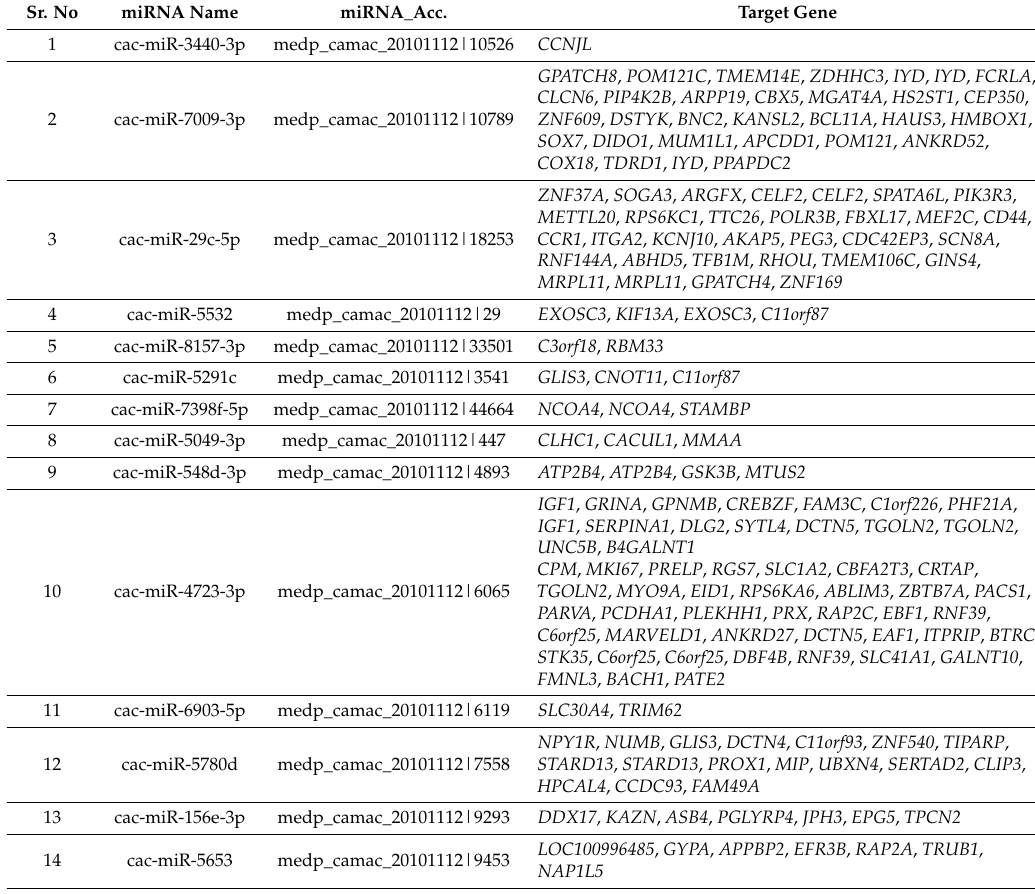
Table 2. Potential target genes of 14 miRNAs identified in Homo